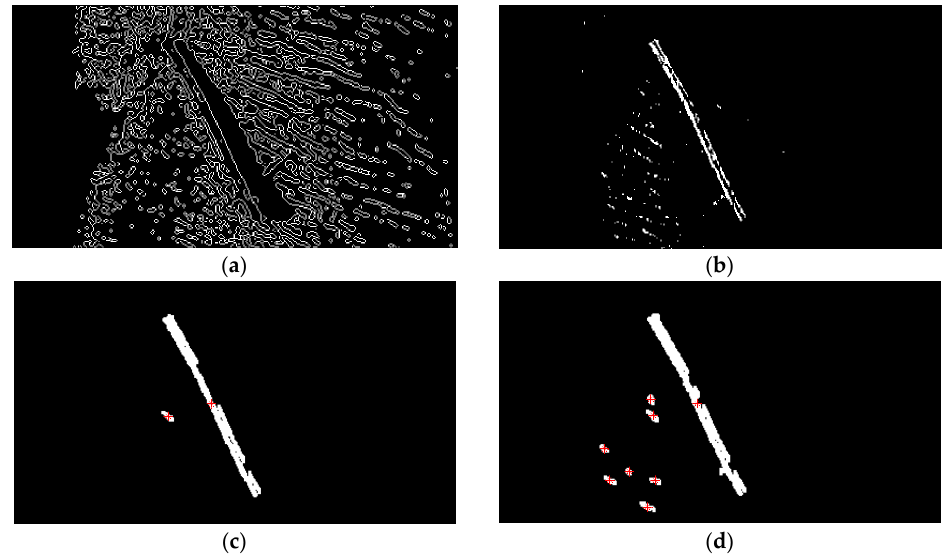
Figure 7. ( a ) Canny contour detection after applying the traditional Otsu method, bw=edge (b, ‘canny’, 0.1255), N 15 = 419 > 100; ( b ) Improved Otsu TSM, T = 0.1137, T* = 0.3529; ( c ) Result of the improved Otsu TSM after morphological operations marking the centroids of the obtained regions; ( d ) Result of the maximum entropy TSM after the same morphological operations marking the centroids of the acquired areas. Table 4. The confusion matrix of real and detected branch centroids using the improved Otsu TSM.